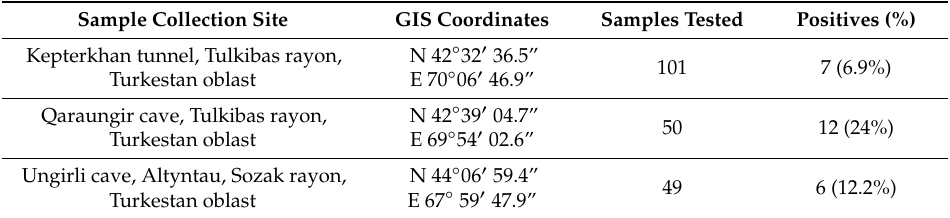
Table 1. The sampling collections of bat guano and PCR positives for coronavirus in Kazakhstan. GIS—geographic information system; N—north;